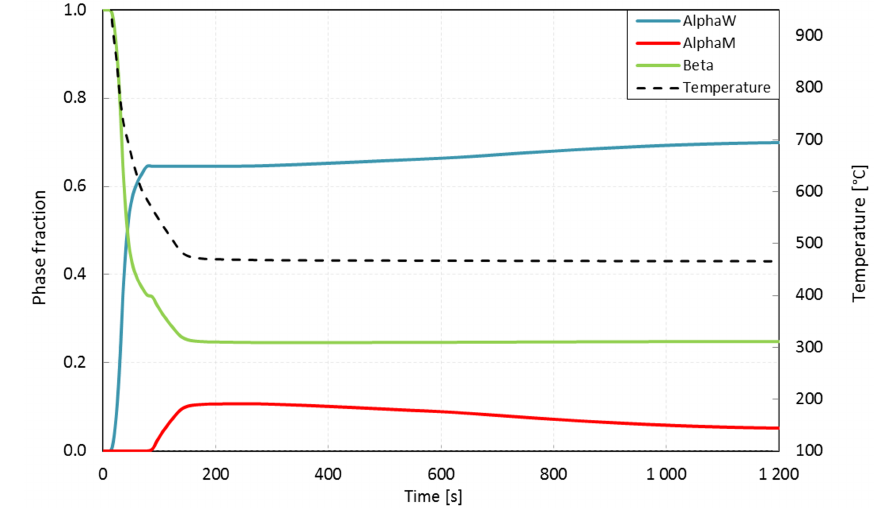
Figure 10. Calculated fraction evolution of Alpha Widmanstatten, Martensite and Beta during a gradual slowing cooling rate